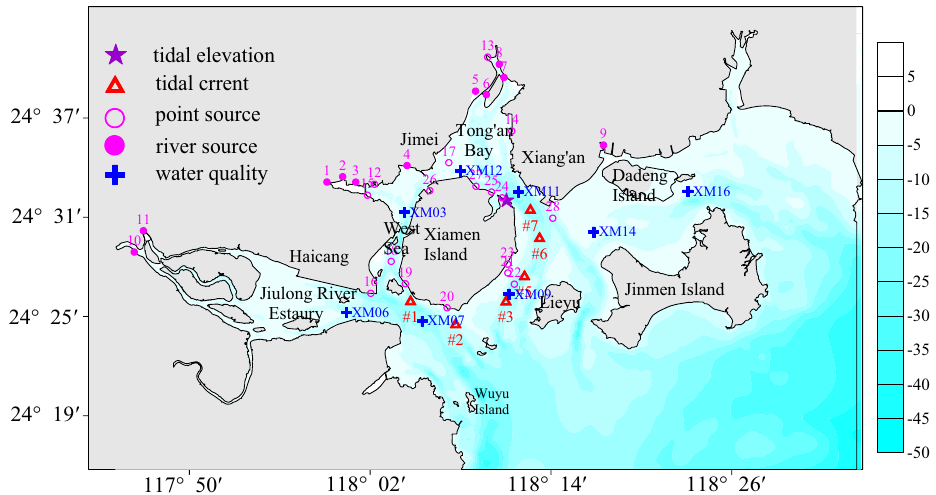
Figure 1. Topography of XMB and location map of stations. #1-#6 indicate the locations of the tidal current stations. 1–11 show the location of river sources and 12–28 show the location of point sources discharged into the XMB. XM03, XM06, XM07, XM09, XM11, XM12, XM14 and XM16 represent the water quality verification stations. The figure was plotted with Surfer10 Software (https:// www. golde nsoft ware. com/ produ cts/